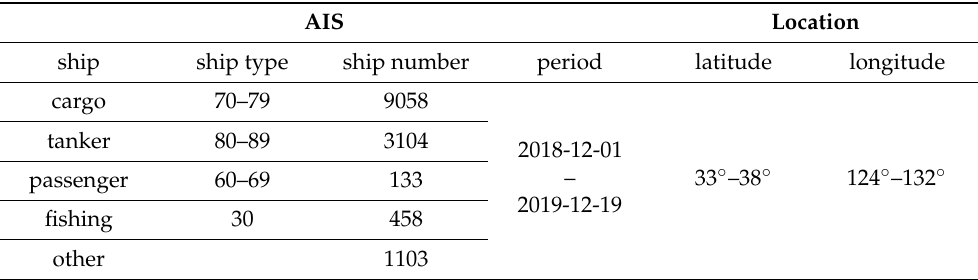
Table 3. Characteristics of AIS Data.